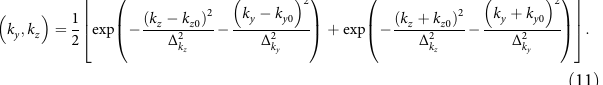
Fig. 4 Electric potential of carbon atom. We plot the DHFS- fi tted scalar potential (blue) for the C atom used in our atomic bremsstrahlung calculations, with the Coulomb potential of the unshielded nucleus (red; Eq. (7) with the speci fi ed parameters, but setting C 1 ¼ 1, C 2 ¼ μ comparison.